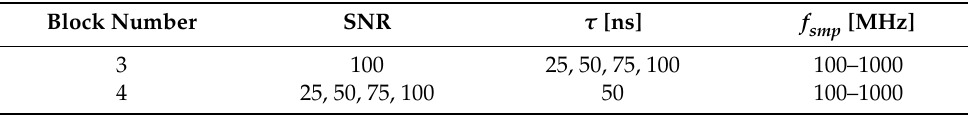
Table 2. Parameters of pulses generated during trials.